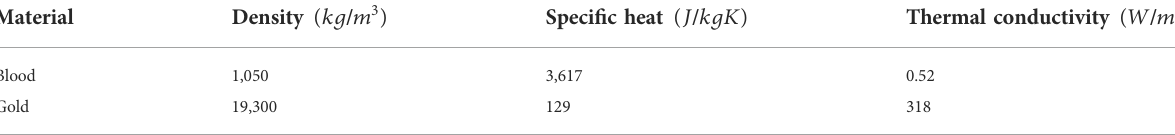
TABLE 1 Thermophysical properties of the base fl uid and nanoparticles.